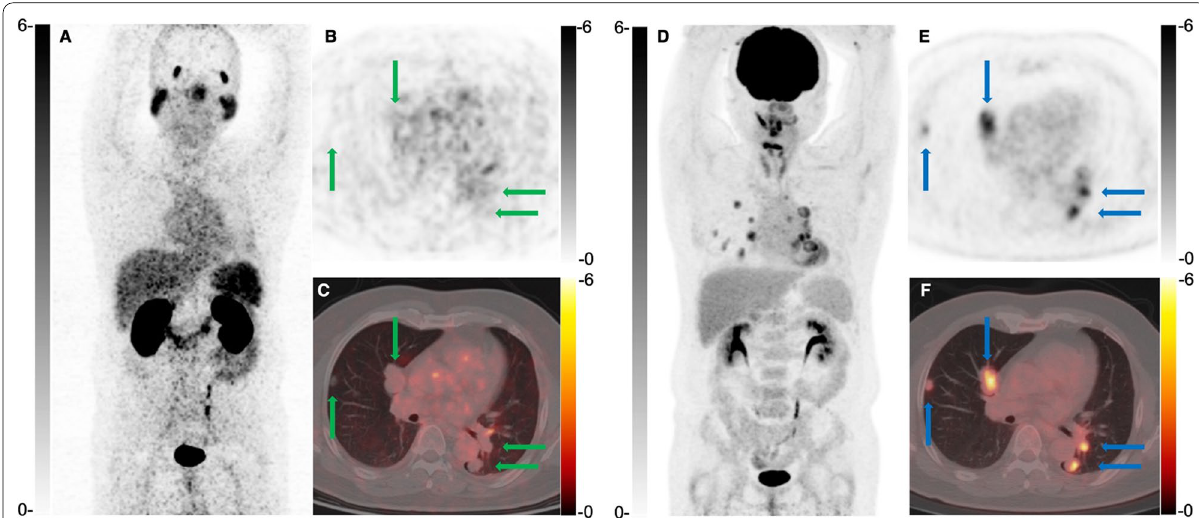
Fig. 4 A 49-year-old man was diagnosed with local recurrence and distant metastases 74 months after surgical removal of a left maxillary ACC. 68 Ga-PSMA PET/CT ( A–C ) showed multiple lung metastases with negligible uptake (green arrow). 18 F-FDG PET/CT ( D – F ) revealed FDG-avid pulmonary lesions (blue arrow, SUVmax